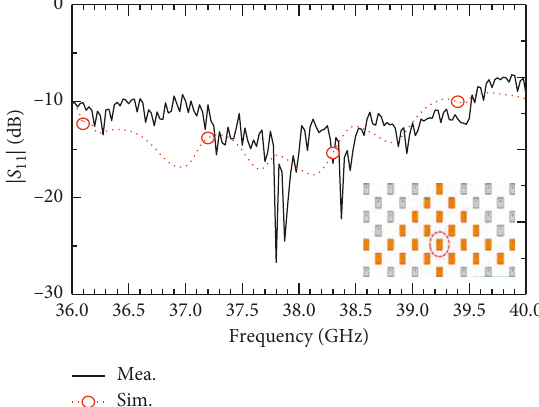
Figure 8: Simulated and measured reflection coefficients of the single patch. The patch is circled in the